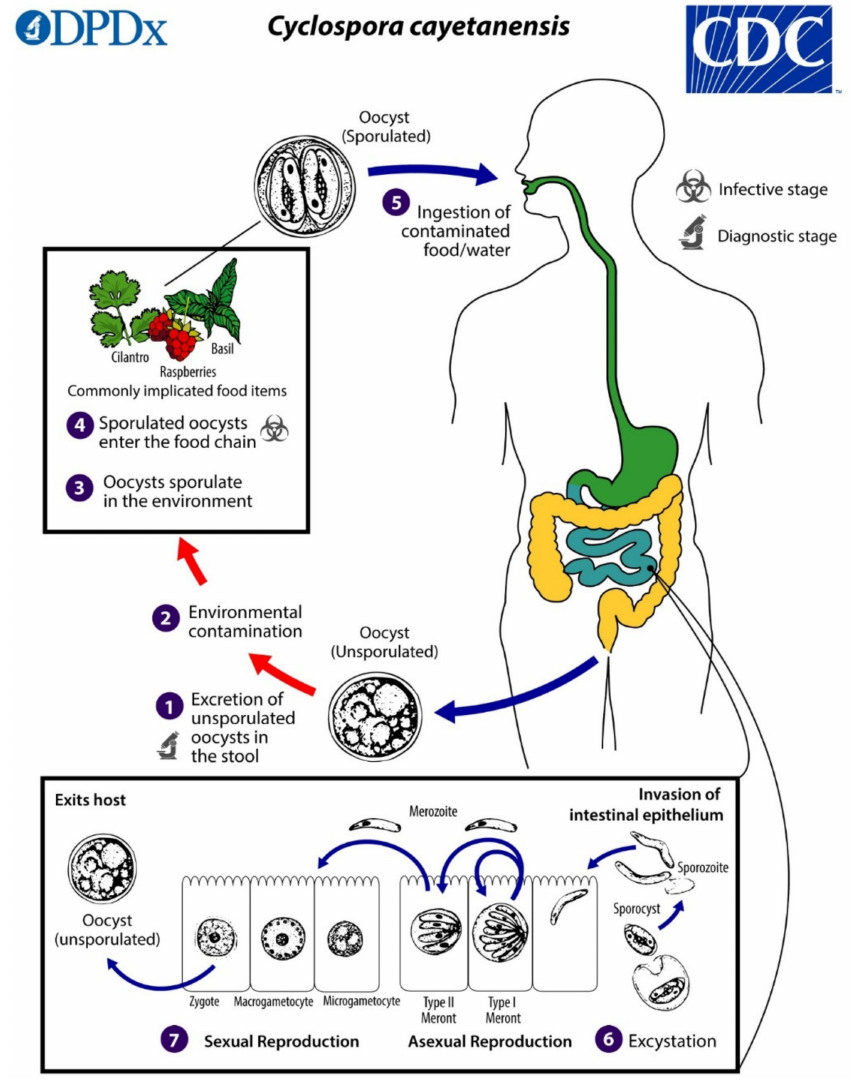
Figure 1. Life cycle of Cyclospora cayetanensis . Unsporulated, non-infective oocysts are passed in the feces ( 1 ). In the environment ( 2 ), sporulation occurs after days or weeks at temperatures between 22 ◦ C to 32 ◦ C, resulting in the division of the sporont into two sporocysts, each containing two elongated sporozoites ( 3 ). The sporulated oocysts can contaminate fresh produce and water ( 4 ) images, which are then ingested ( 5 ). The oocysts excyst in the gastrointestinal tract, freeing the sporozoites, which invade the epithelial cells of the small intestine ( 6 ). Inside the cells, they undergo asexual multiplication into Type I and Type II meronts. Merozoites from Type I meronts perpetuate the asexual cycle, while merozoites from Type II meronts undergo sexual development into macrogametocytes and microgametocytes upon invasion of another host cell. Fertilization occurs, and the zygote develops to an oocyst, which is released from the host cell and shed in the stool ( 7 ). Figure courtesy of the